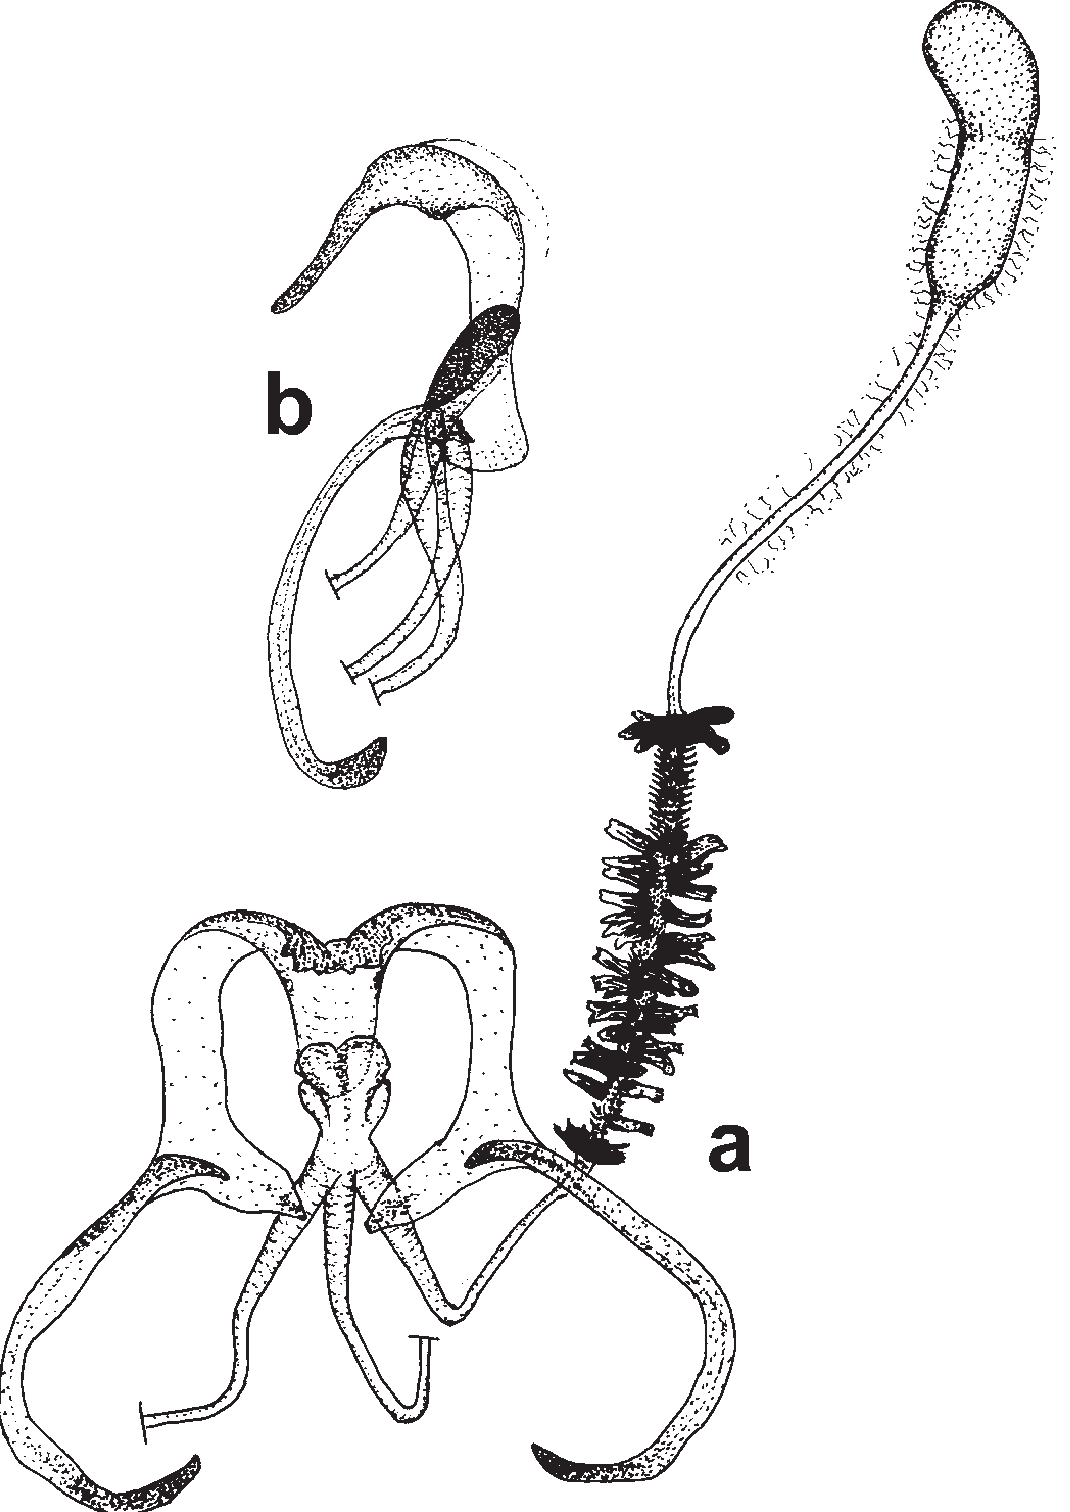
Fig. 51. Protypusia modesta (Loew, 1873) gen. et comb. nov. a . Female genitalia ventral. b . Female genitalia